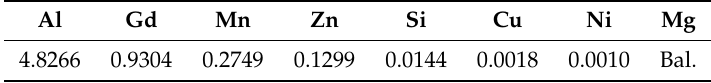
Table 1. Chemical composition of the tested AM50Gd alloy (%, mass fraction).